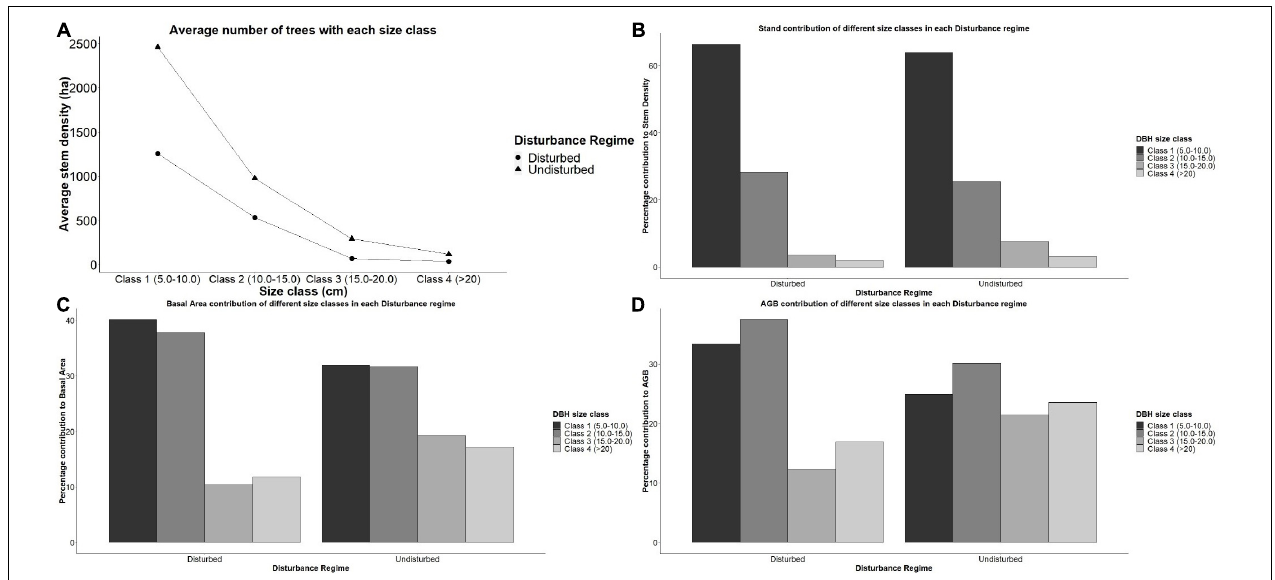
FIGURE 4 | Percentage contribution of size classes to within plots of the same disturbance group. (A) Average number of trees with each size class. (B) Stand contribution of different size classes in each Disturbance regime. (C) Basal Area contribution of different size classes in each Disturbance regime. (D) AGB contribution of different size classes in each Disturbance regime. TABLE 2 | Proportion of diameter at breast height (DBH) size classes contributing to stand density, basal area, and aboveground biomass (AGB) in different disturbance regime. Disturbance regime DBH size Number of class (cm) stems